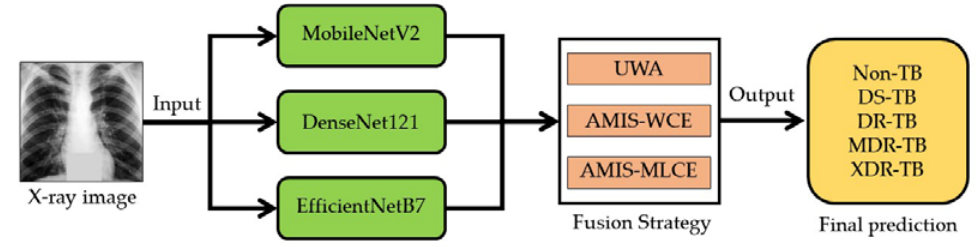
Figure 9. Structure of the EDL using Heterogeneous and Heterogeneous manners .